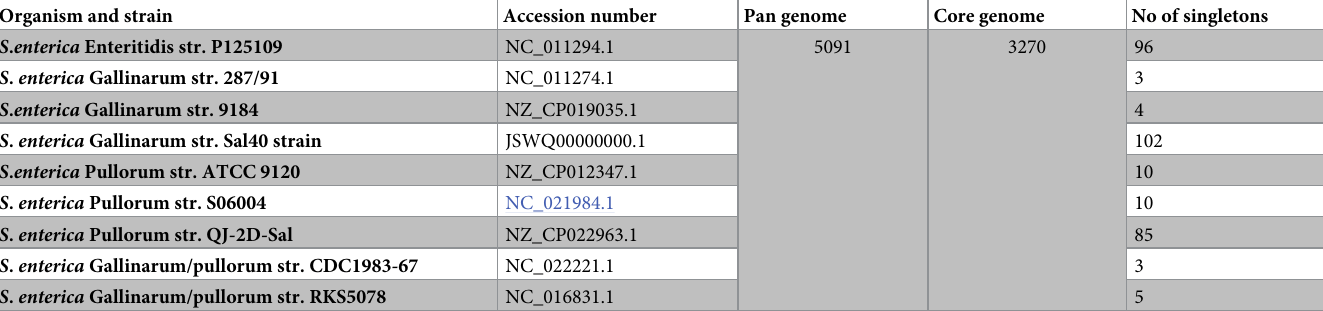
Table 2. Number of CDS identified in pan genome, core genome and singletons of the investigated Salmonella genomes. Organism and